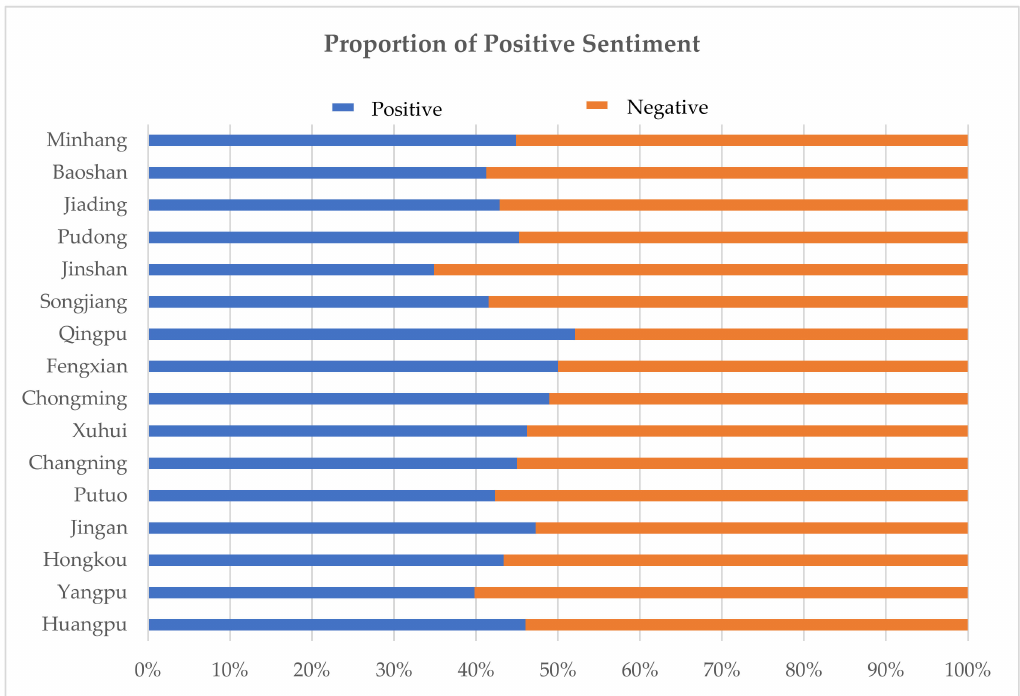
Figure 8. Proportion of positive